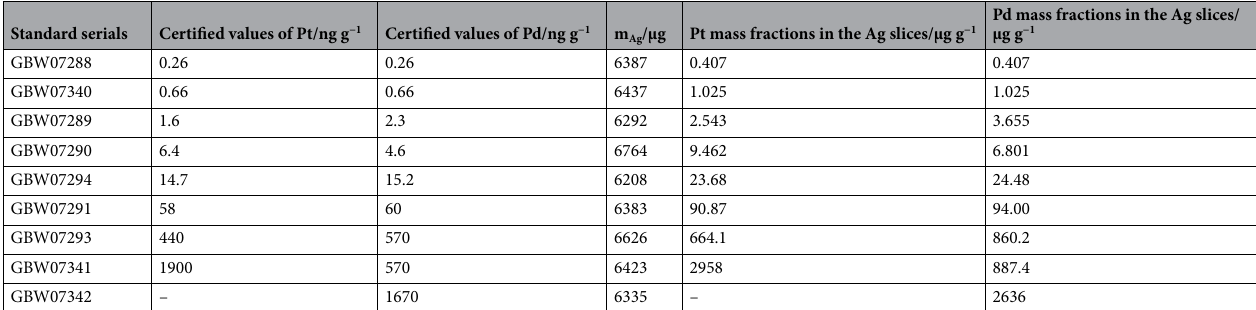
Table 5. The mass fractions of Pt and Pd in the Ag slices of CRMs.